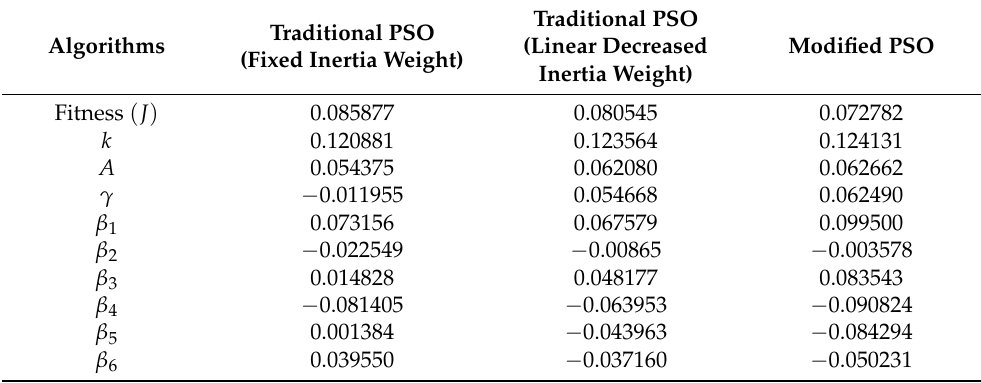
Table 5. Parameter identification result with different